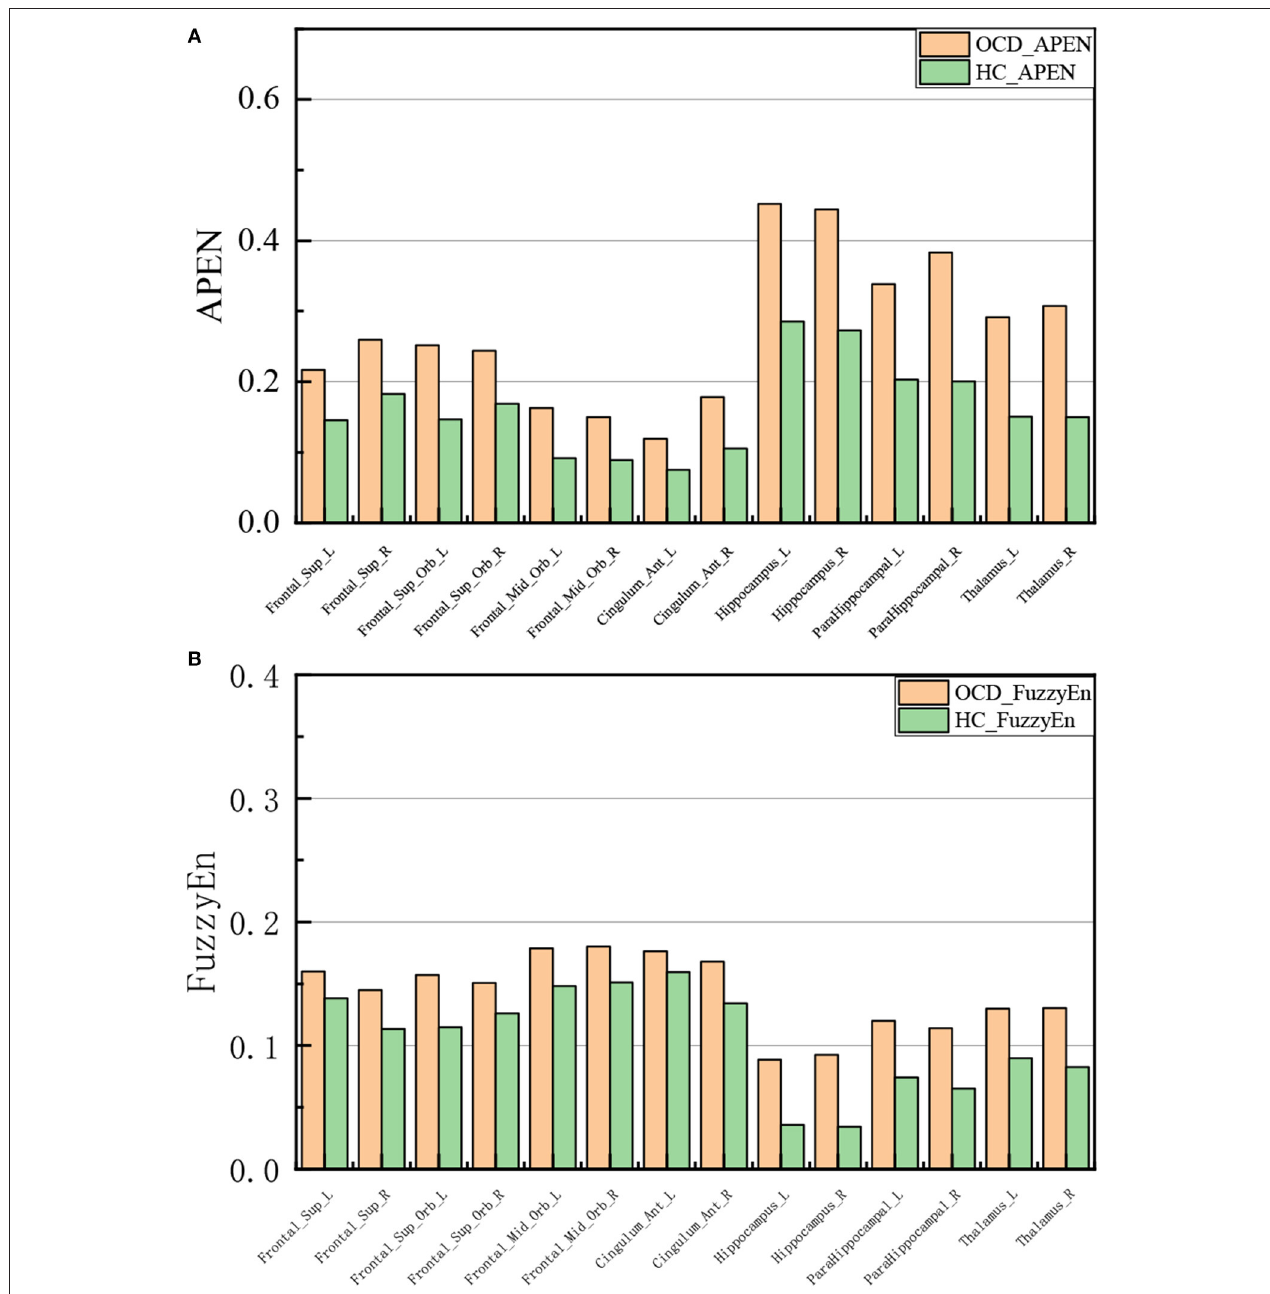
FIGURE 3 | Brain regions with statistical differences between OCD and HC. (A) ApEn (B)